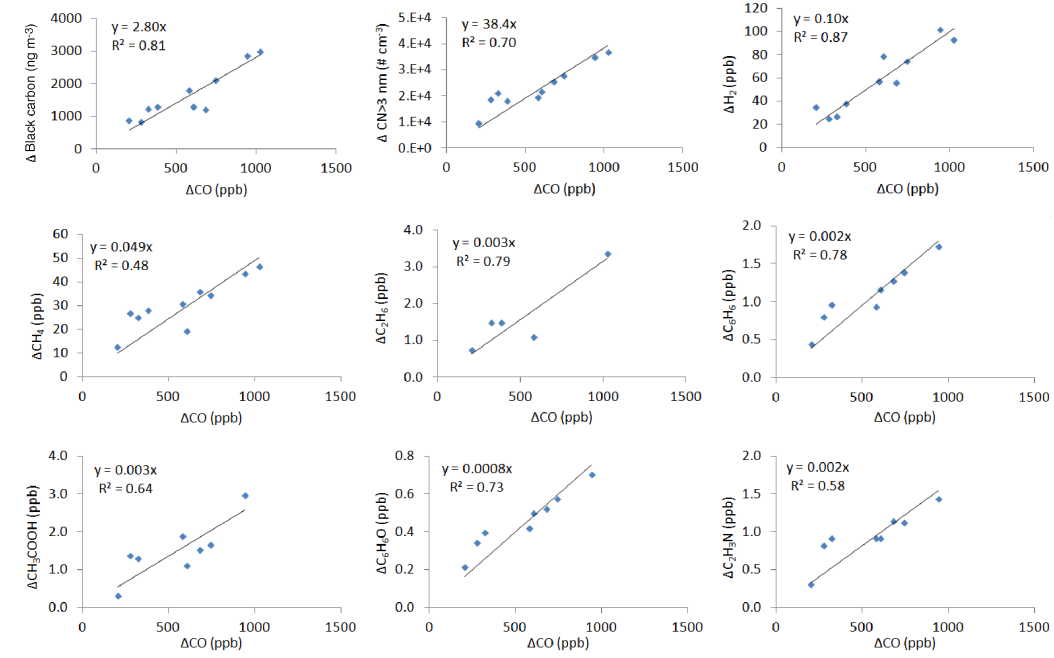
Figure 7. Emission ratios (ER) of several trace gas and aerosol species to CO during Period A in